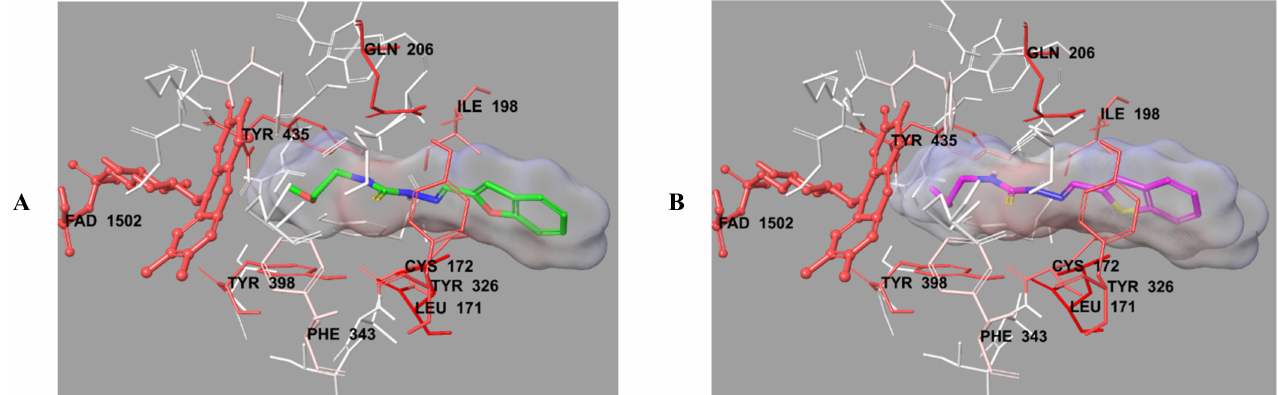
Figure 8. The van der Waals interactions of compounds 2b ( A ) and 2h ( B ) with active region of h MAO-B. The active ligands has a lot of favorable van der Waals interactions (red and pink).